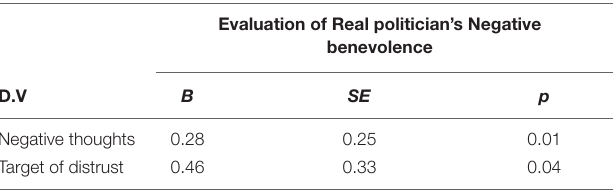
TABLE 3 | Regression predicting negative thoughts and target of